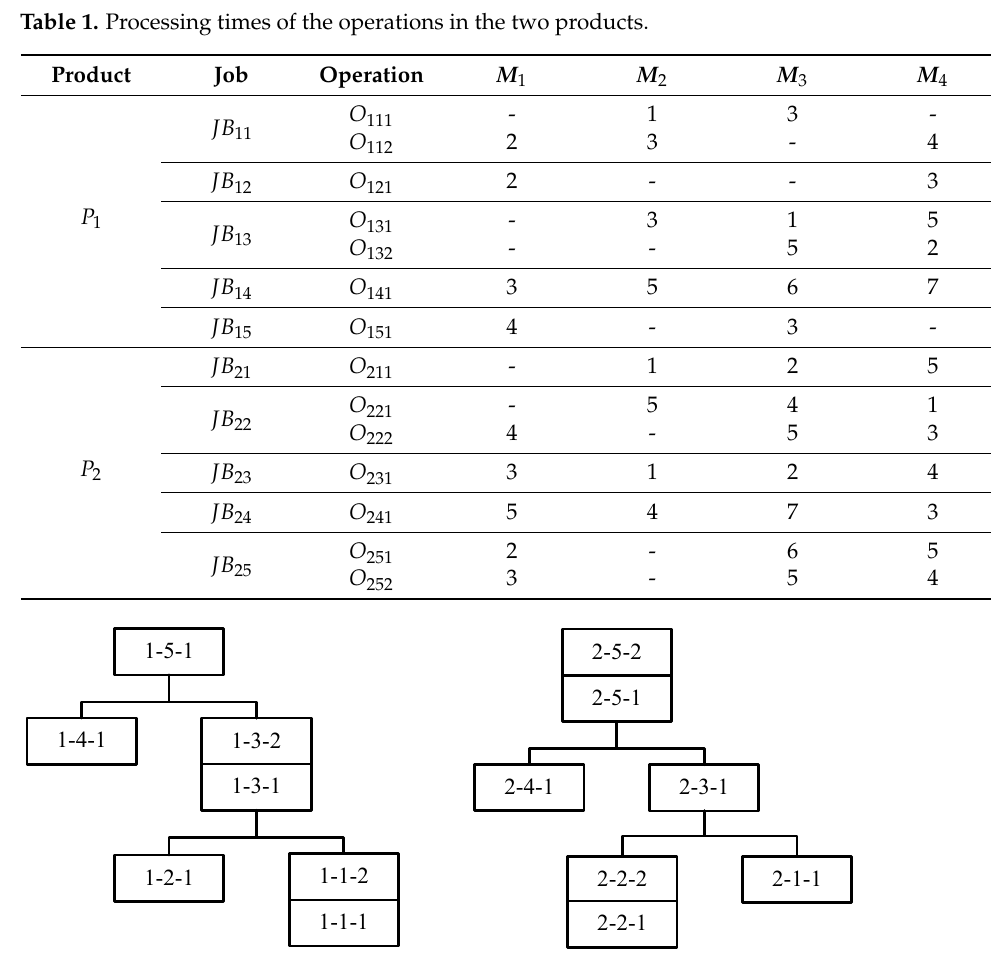
Figure 1. The tree-like structure of the products.